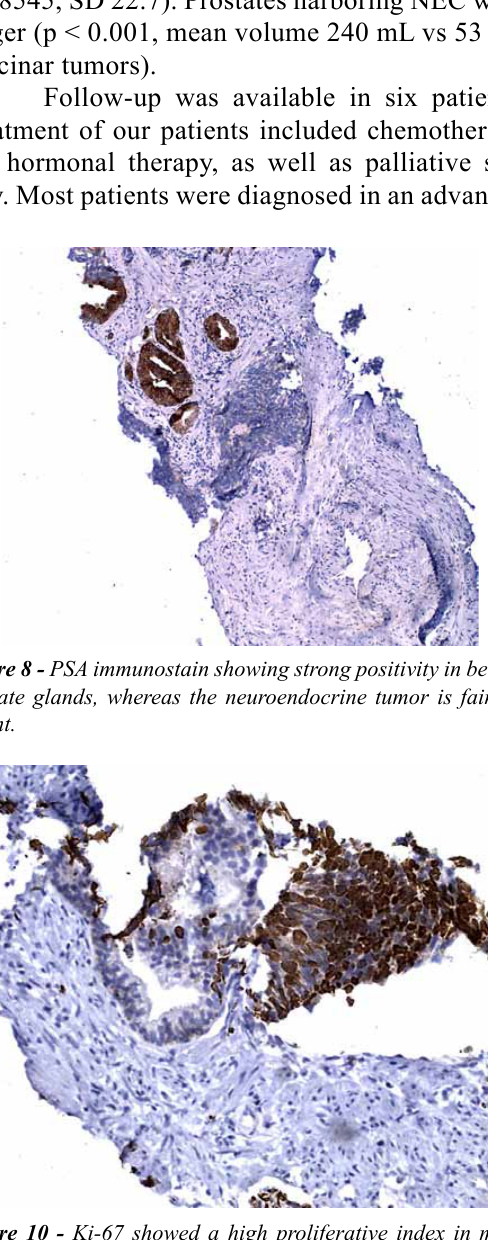
Figure 10 - Ki-67 showed a high proliferative index in most neuroendocrine